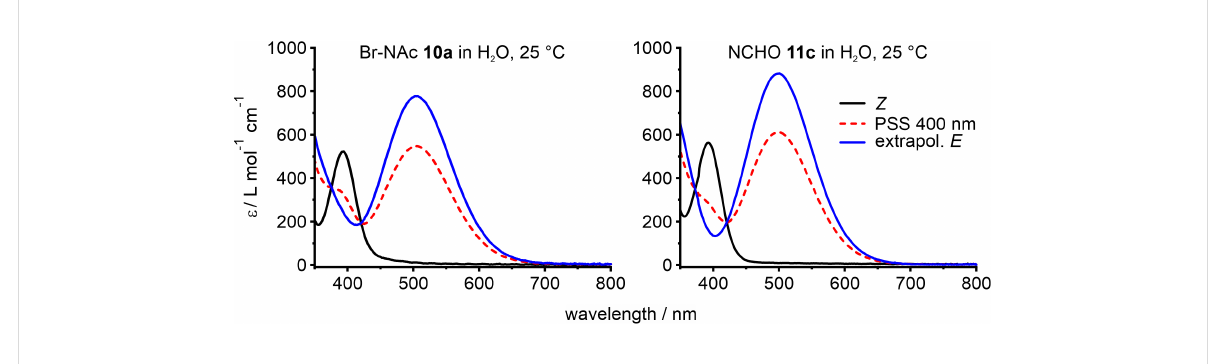
Figure 3: UV–vis spectra of 3-bromo- N Ac-diazocine 10a and N -formyl-diazocine 11c in water. Spectra of Z -isomers (black curve), the photosta- tionary states at 400 nm (dashed red line), and the extrapolated spectra of the pure E -isomers (blue).